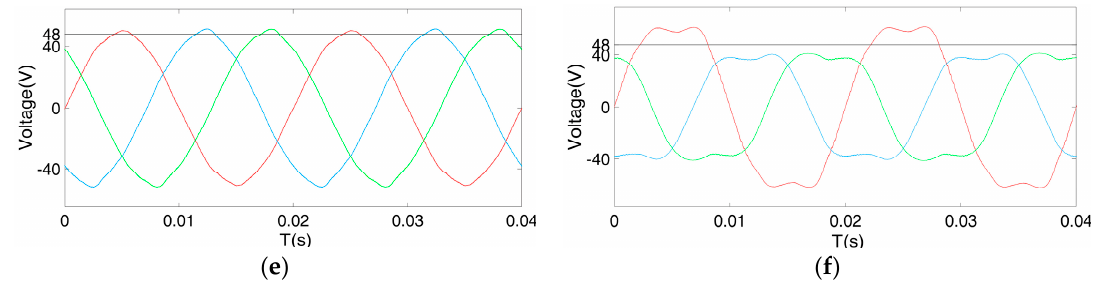
Figure 9. Waveforms for the “577” operation state: the ( a ) three-phase converter output voltage; ( b ) three-phase line-to-line voltages; ( c ) grid current; ( d ) three-phase sub-module modulating waveform;